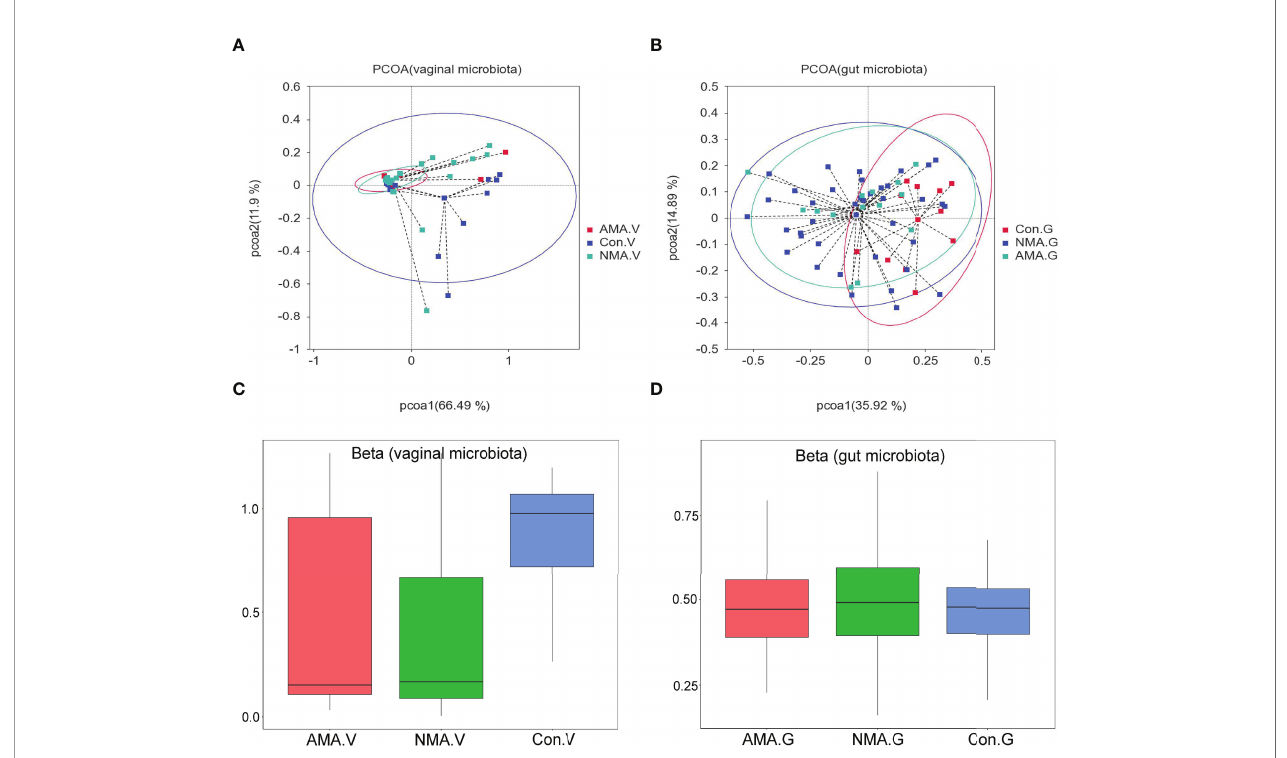
FIGURE 2 | (A, B) PCoA (principal coordinates analysis) based on weighted UniFrac distance. (C, D) Beta diversity index differences between groups (Wilcoxon test). The abscissa represents a principal component, the ordinate represents another. The percentage represents the contribution value of the principal component to the sample difference. Each dot represents a sample, and samples in the same group are indicated in the same